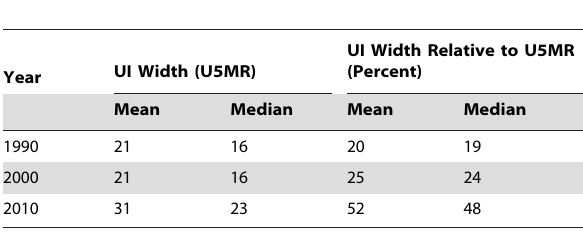
Table 3. Overview of width of uncertainty bounds for U5MR in 1990, 2000, and 2011 for 86 high mortality